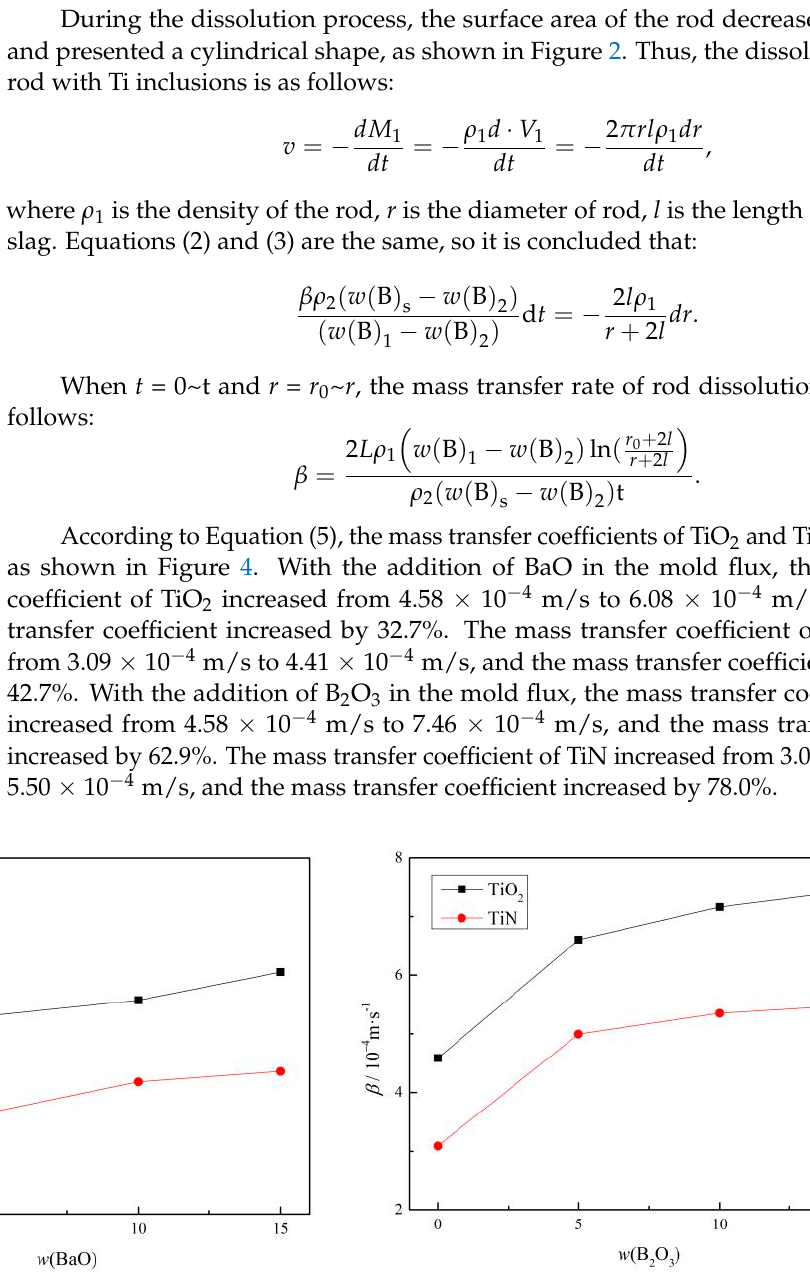
Figure 4. The mass transfer coefficient of the rod with Ti inclusions in different mold fluxes.